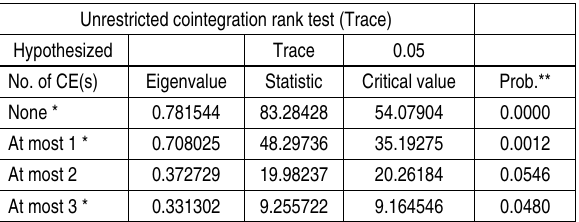
Table 3. Results of Johansen cointegration test Unrestricted cointegration rank test (Trace)